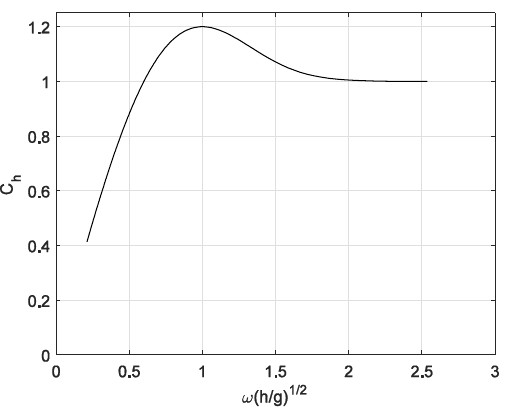
Figure 3. Modification coefficient of celerity in a non-dimensional form.